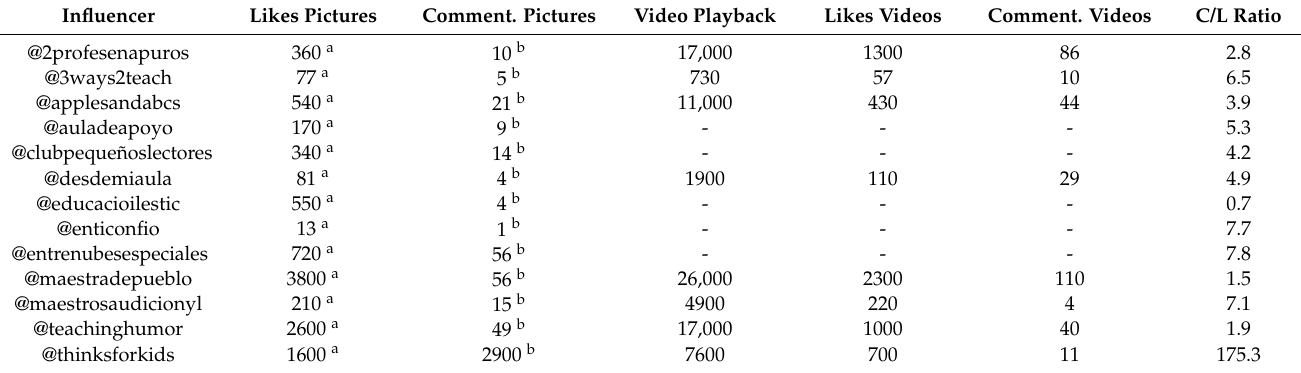
Table 5. Impact of